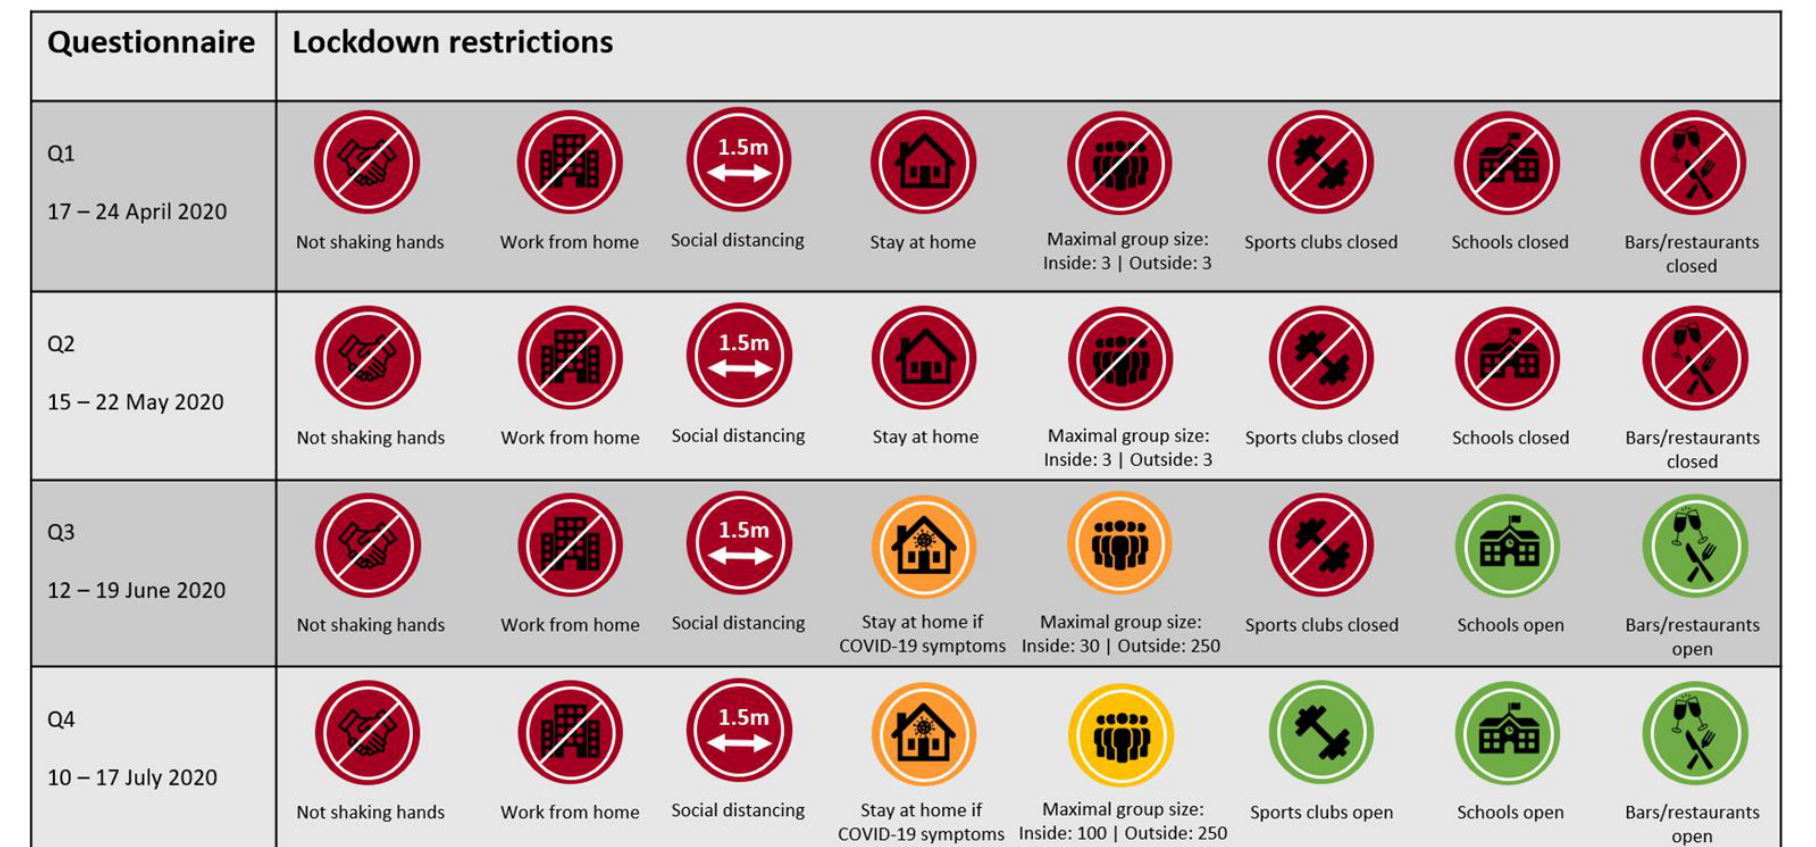
Figure 1. Overview of lockdown restrictions in the Netherlands applicable at the time of the assessment of physical activity and sedentary behaviour during the first-wave of COVID-19.